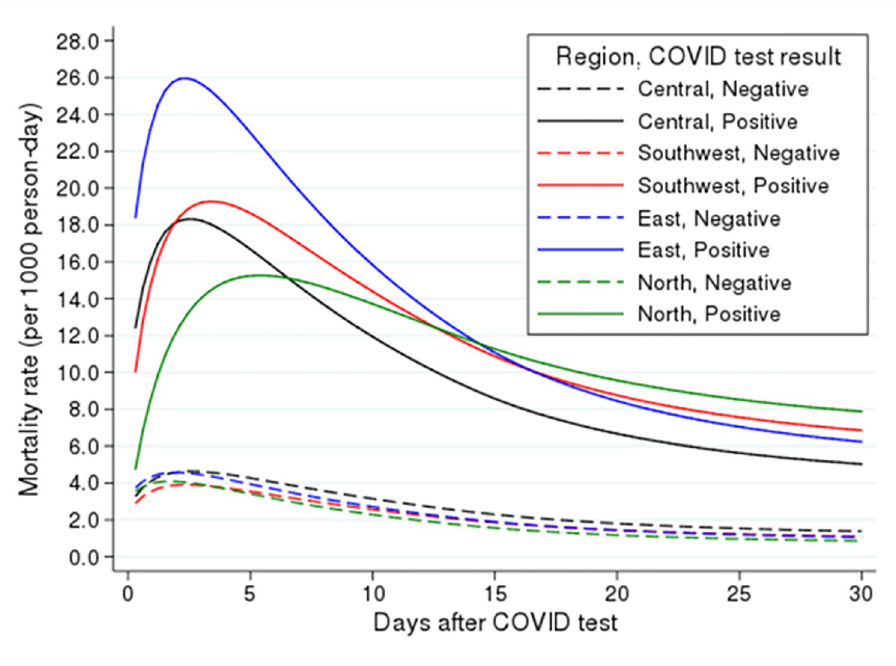
Fig 2. Adjusted mortality rate based on region and COVID-19 test result adjusted for sex, age group, Changes in Health, End-stage disease and Symptoms and Signs (CHESS) scale, frailty, and long-term care home ownership.